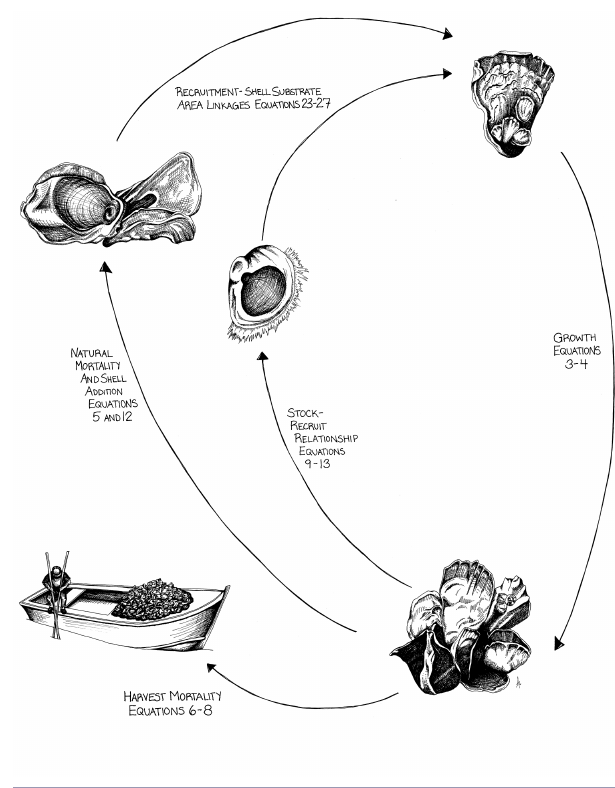
Fig. 1 . Generalized eastern oyster (Crassostrea virginica) lifecycle and equations used in the stock assessment model (Table A2.1 in Appendix 2) developed to assess status and trends in the Apalachicola oyster